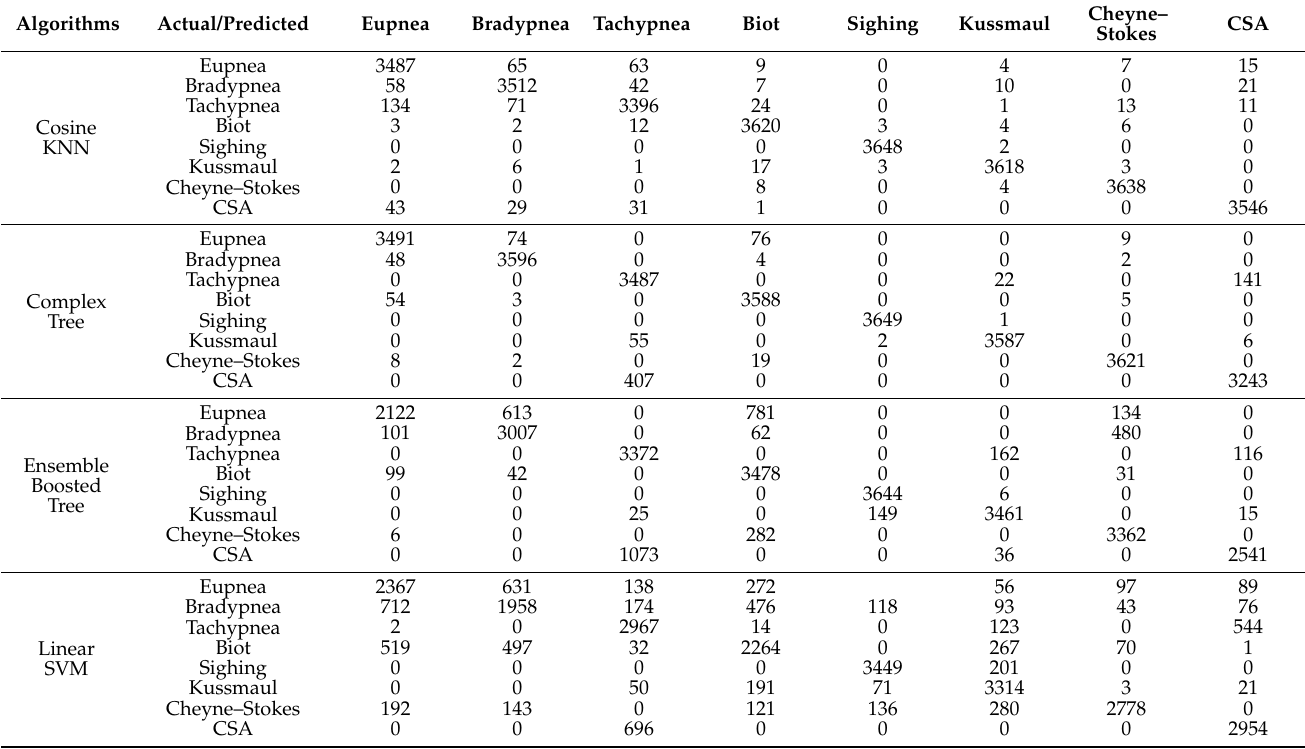
Table 4. Confusion matrix for real-time breathing